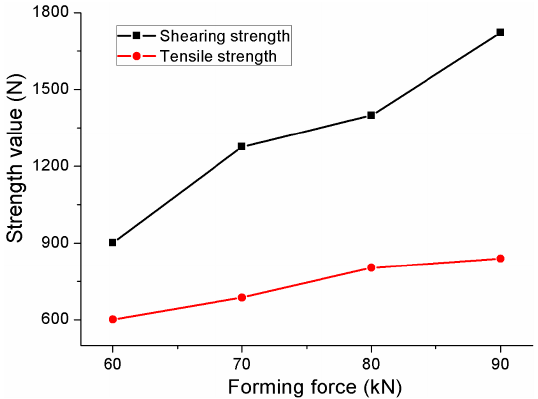
Figure 15. Shearing and tensile strengths of the improved clinched joints.